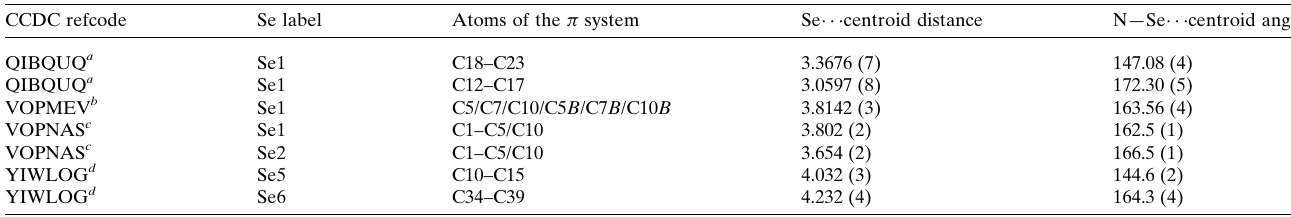
Table 2 Chalcogen bonds (A˚ , (cid:3) ) observed in benzoselenadiazole fragments in the CSD. CCDC refcode Se label Atoms of the (cid:2) system